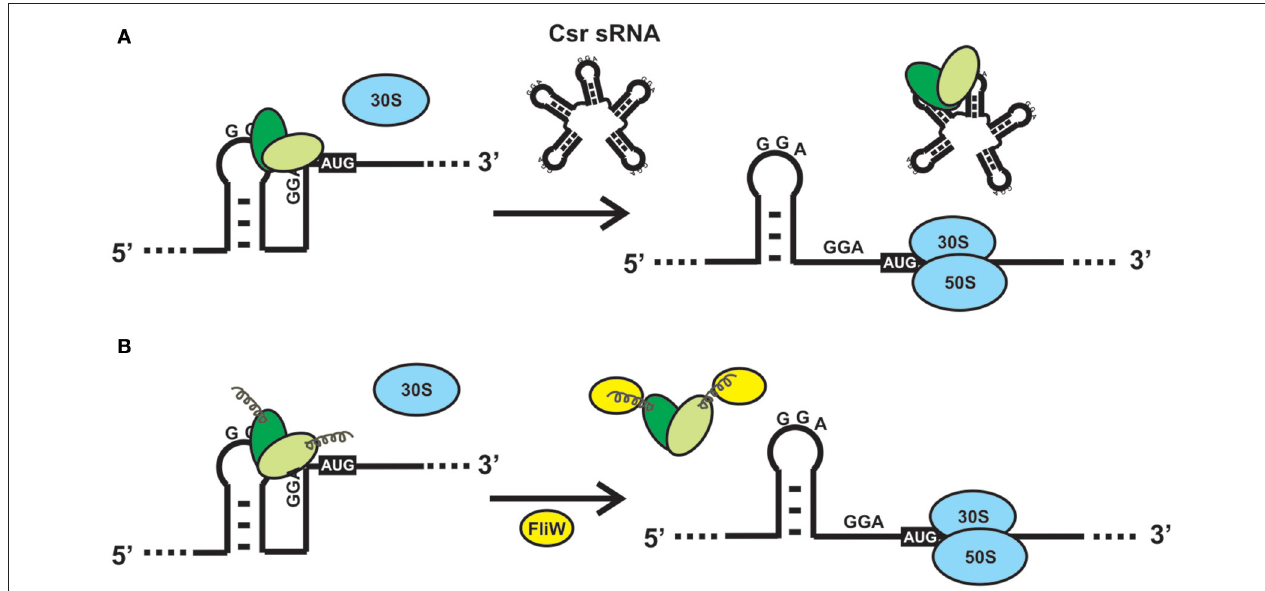
FIGURE 4 | Alternative mechanisms to relieve the direct or indirect effects of CsrA binding to a mRNA. (A) Sequestration of CsrA by molecular mimic sRNAs. The sRNAs of the Csr/Rsm family act like protein sponges by offering multiple sequence/structural motifs that fulfill the features shown in Figure 2F . The availability of CsrA dimers for binding to multiple mRNAs is modulated by the intracellular concentration of one or more of these molecular mimic sRNAs. (B) CsrA can be displaced from its mRNA substrates upon interaction of a protein like FliW of B. subtilis with the extended C-terminal region (Altegoer et al., 2016). Such interaction provokes a conformational change in the protein dimer that reduces the affinity for the